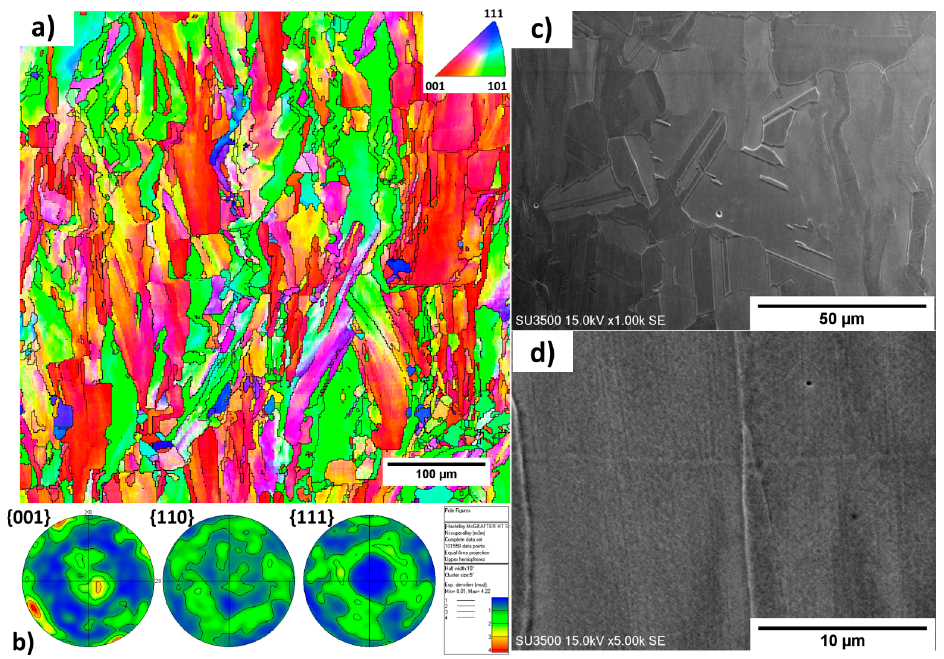
Figure 5. ( a ) EBSD map taken from the central region of the sample after heat treatment, and ( b ) its corresponding pole figure. SEM micrographs taken at ( c ) 5000× and ( d ) 1000× showing the microstructure of the sample after heat treatment.